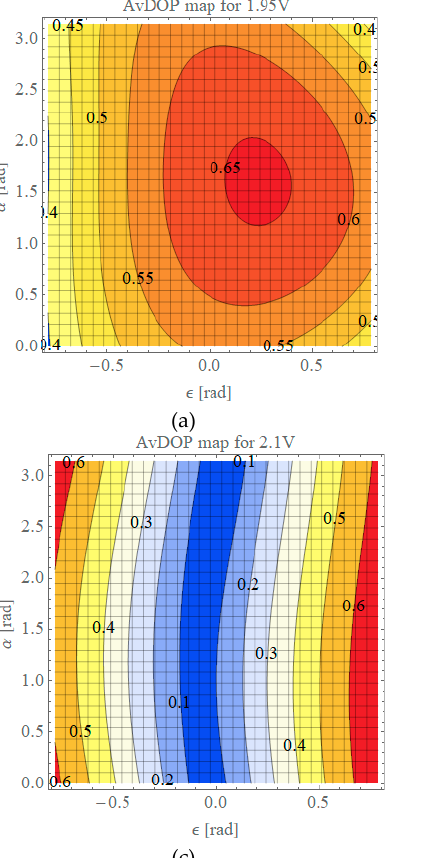
Figure 6. Calculated: ( a ) diattenuation and ( b ) retardance of tested PVAN cells with thicknesses of 10 μ m (blue dotted line) and 15 μ m (dot-dashed line).